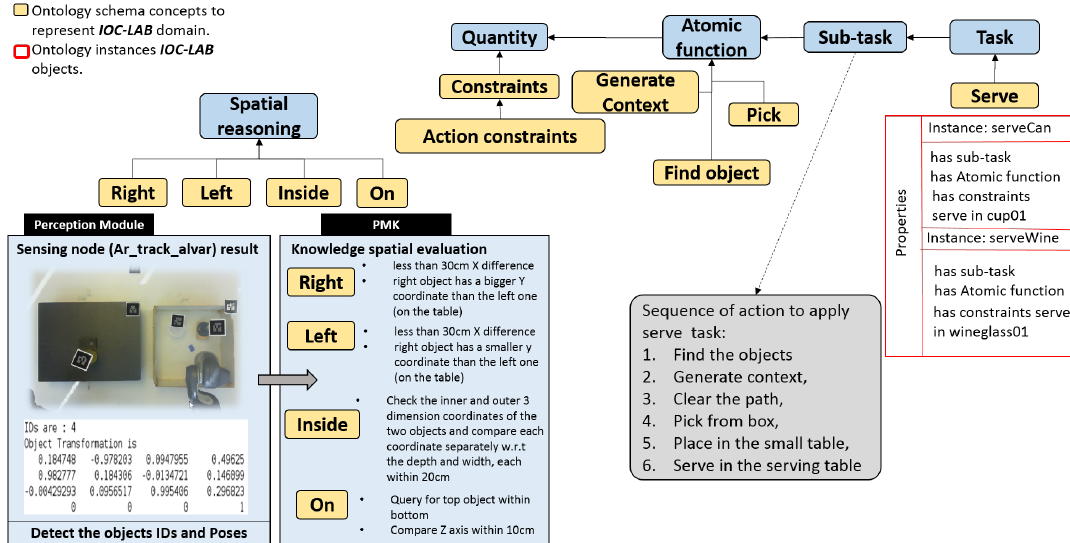
Figure 10. Schema of the flow of information between classes that belong to the metaontology, ontology schema, and ontology instance layers of manipulation planning classes. On the left, the flow of asserted data from perceptual module and the spatial evaluation process. On the right, the task and the sequence of actions needed to execute